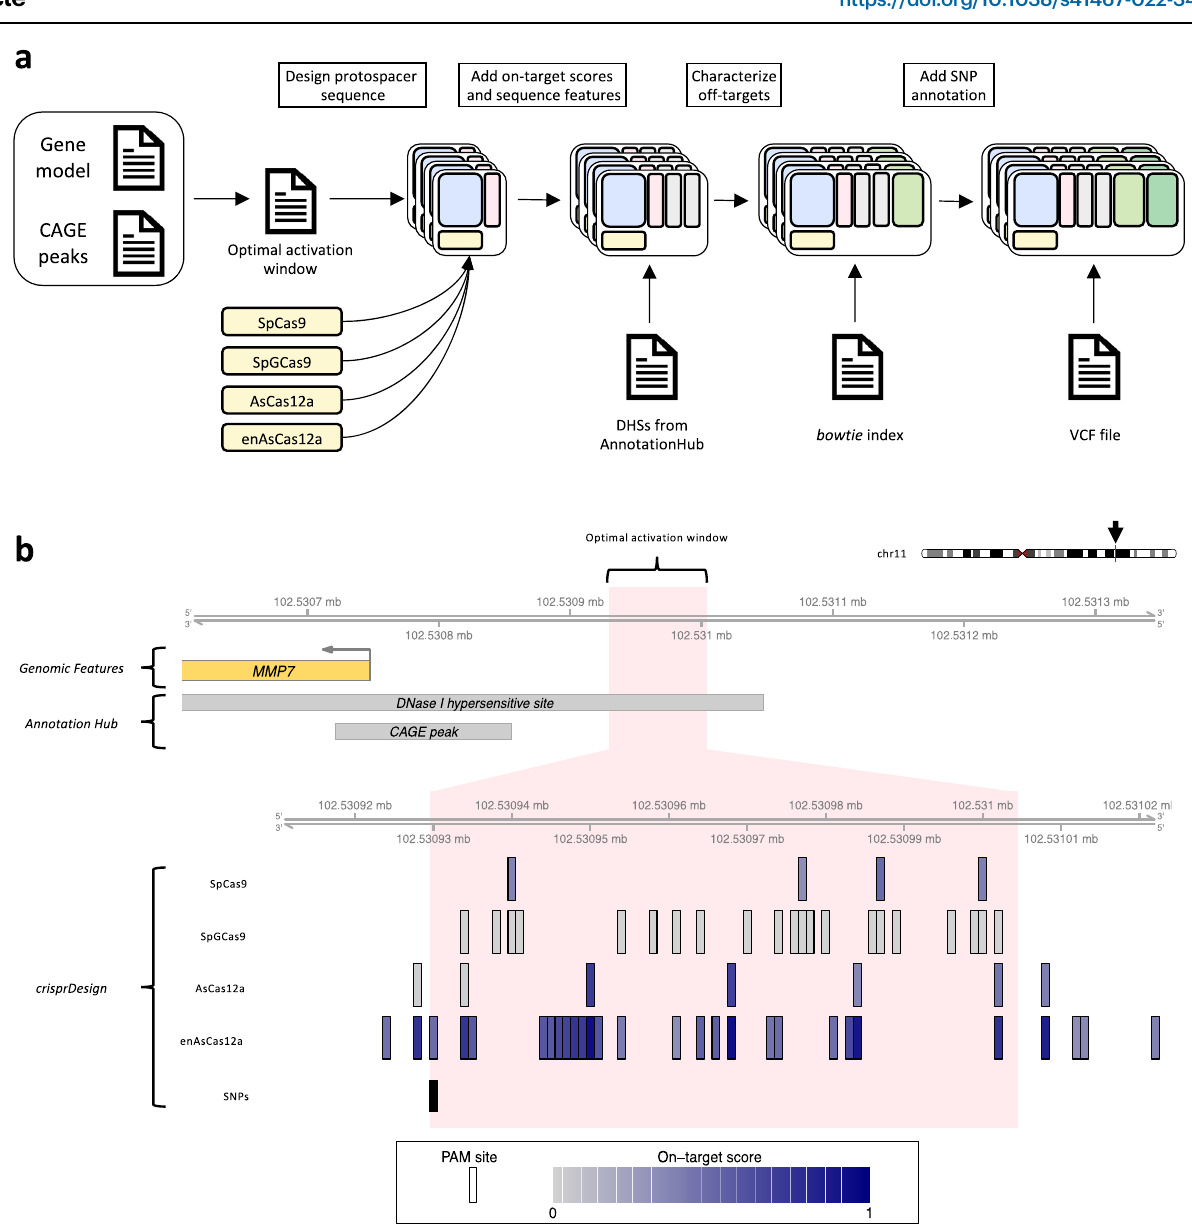
were obtained using AnnotationHub (see Methods). The light pink region corre- sponds to the optimal region of activation, corresponding to a region [75,150]bp upstreamofthe5 0 endoftheCAGEpeak.Foreachofthefourselectednucleases,all canonical PAM sites located within the optimal region are shown. PAM sites are colored by their on-target score: DeepHF for SpCas9, DeepCpf1 for AsCas12a, and enPAM+GBforenAsCas12a.Noon-targetscoringalgorithmwasavailableattimeof publication for SpGCas9. The last track corresponds to common SNPs obtained from